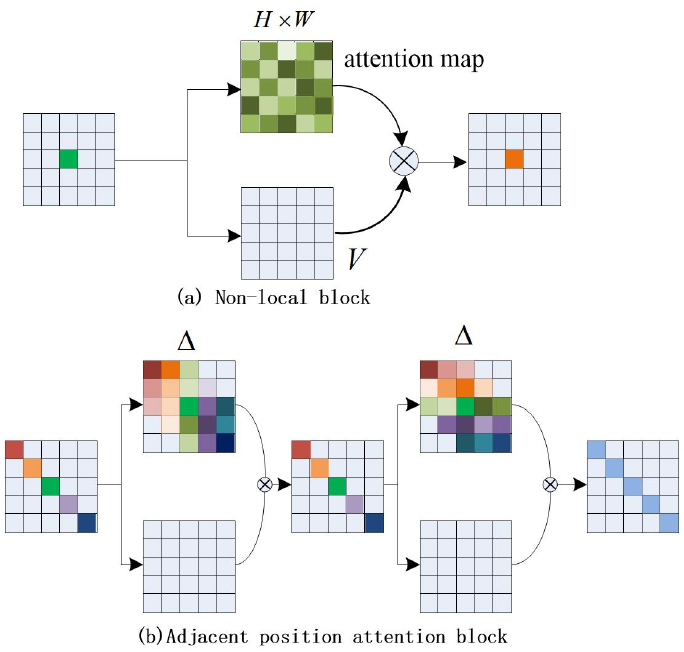
Figure 1. Diagram of two attention-based contextual aggregation